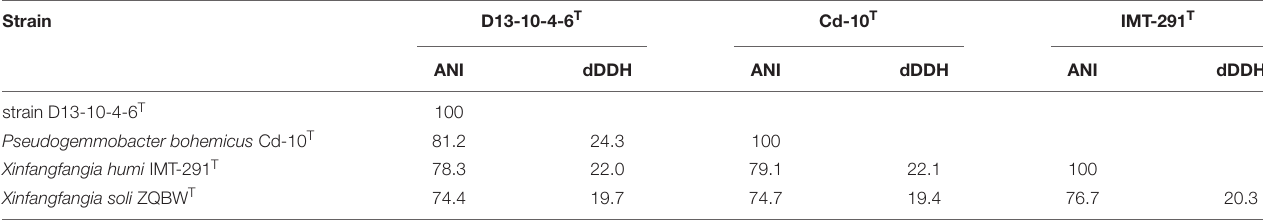
TABLE 1 | Average nucleotide identity (ANI), digital DNA–DNA hybridization (dDDH) values among D13-10-4-6 T , P. bohemicus Cd-10 T , X. humi IMT-291 T , and Xinfangfangia soli ZQBW T . Strain